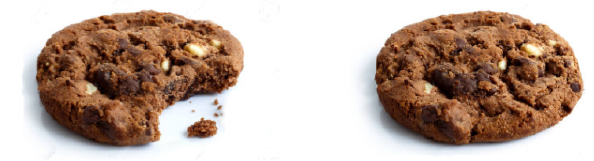
Figure 1. The used stimuli for Study 1.